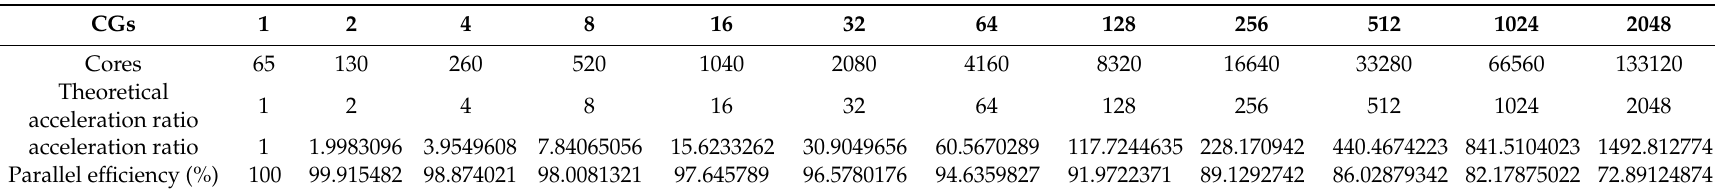
Table 2. Acceleration ratio and e ffi ciency based on a single core-group (CG) with the highest number of 2048 CGs (a total of 133,120